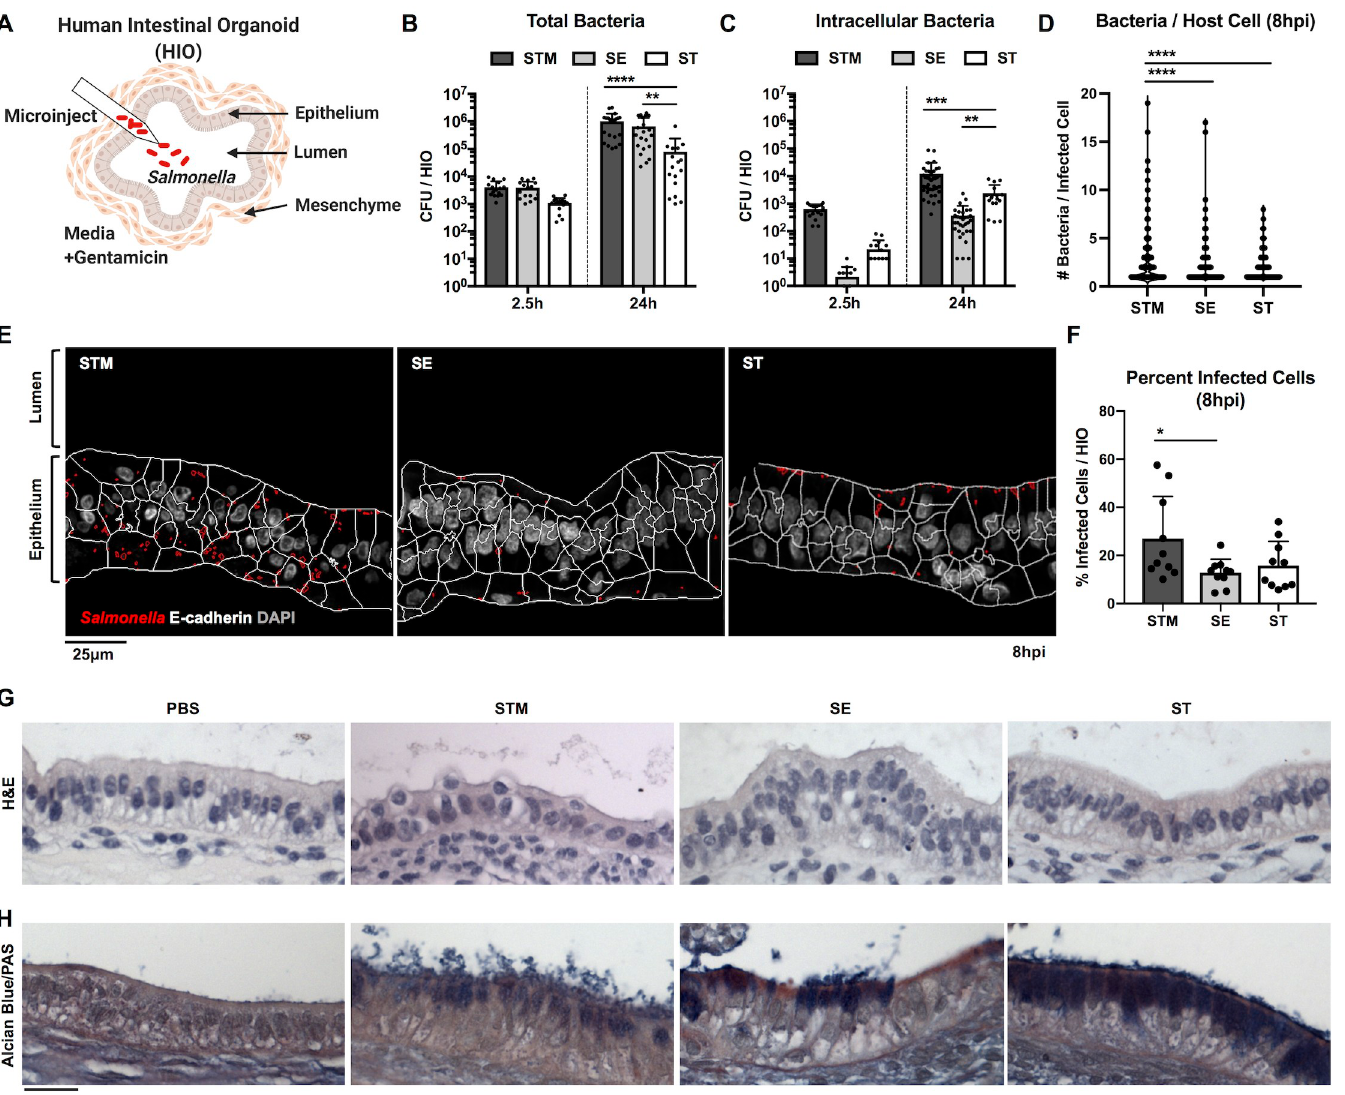
Fig 1. Salmonella enterica serovars invade HIO epithelial cells and stimulate mucin production. (A) Model depicting experimental set-up with the HIOs. HIOs are comprised of an epithelium lining surrounded by mesenchymal cells that self-organize into 3-dimensional structures. Bacteria (10 3 CFU) were microinjected into the HIO lumen and gentamicin was added to the medium after 2h to kill any bacteria introduced into the medium during microinjection. (B) Total bacterial burden was enumerated per HIO at 2.5h and 24h post infection. (C) Intracellular bacterial burden was enumerated after exposing luminal bacteria to gentamicin at 2.5h and 24h post infection. Graphs represent the mean of n > 16 HIOs from three independent experiments. Statistical significance within the group was determined by two-way ANOVA and followed up by Tukey’s multiple comparisons test. (D) Number of bacteria per cell was quantified using DAPI staining. (E) Representative confocal microscopy images of histology sections obtained from STM, SE, or ST infected HIOs for 8h. Sections were stained for E-cadherin and DAPI. Cell outlines based on the E-cadherin staining (white) and bacterial outlines detected using DAPI staining (red) were generated using CellProfiler. (F) Percent of infected cells were determined by quantifying 3 fields of view per HIO at 60x magnification with n = 10 HIOs analyzed per group. (G and H) Histology sections of HIOs at 8hpi using hematoxylin and eosin (H&E) staining (G) and Alcian Blue/Periodic Acid-Schiff (PAS) staining (H). Statistical significance for (D) and (F) was determined by one-way ANOVA with Tukey’s multiple comparisons test. P values < 0.05 were considered significant and designated by: � < 0.05, �� < 0.01, ��� < 0.001 and ���� < 0.0001.